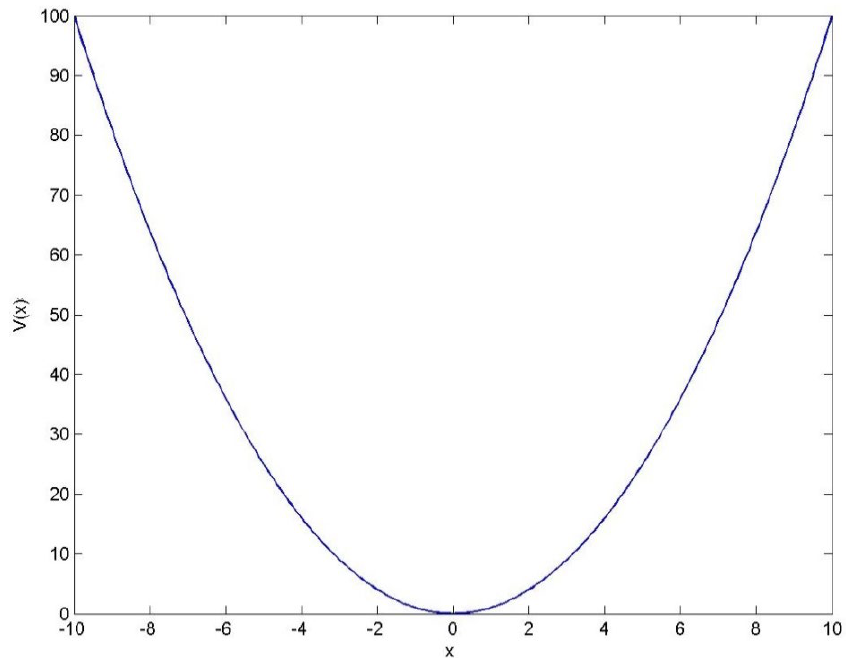
Figure 3. Variation of V ( x ) (Equation (16)) with x .